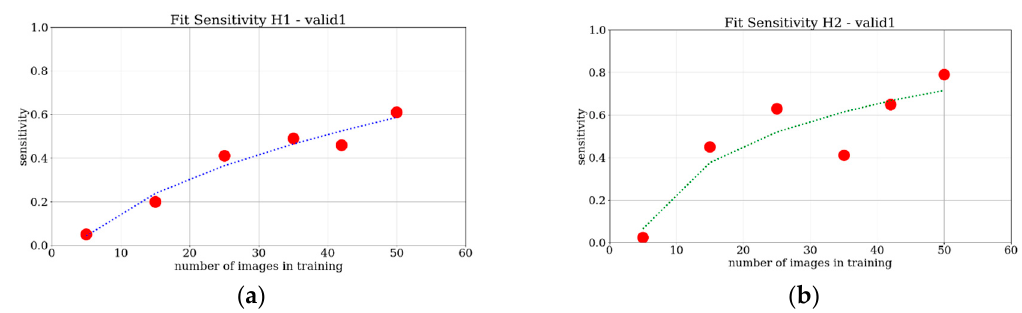
Figure 18. Real values (red dots) and fitting curves (dotted line) of sensitivity analysis: ( a ) for H1 with valid1 and threshold equal to 0.9; ( b ) for H2 with valid1 and threshold equal to 0.9.